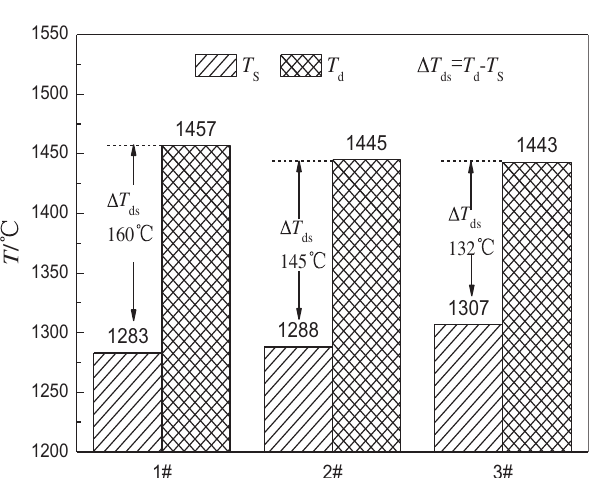
Figure 3: T S and T d with different w (Cl - ).